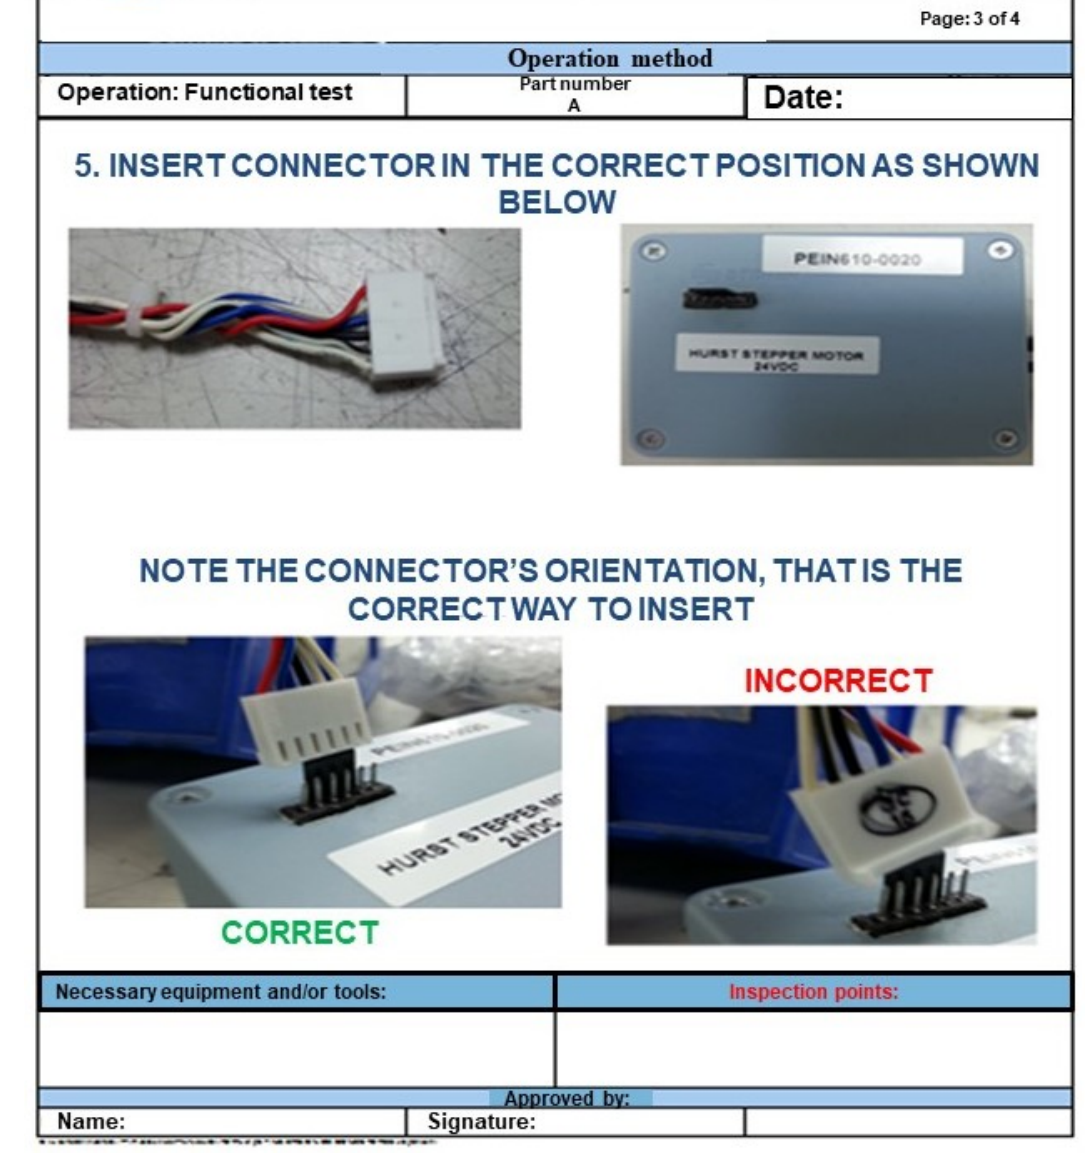
Figure 3. Third Visual Aid to Conducting the Functional Test. Figure A3. Third Visual Aid to Conducting the Functional